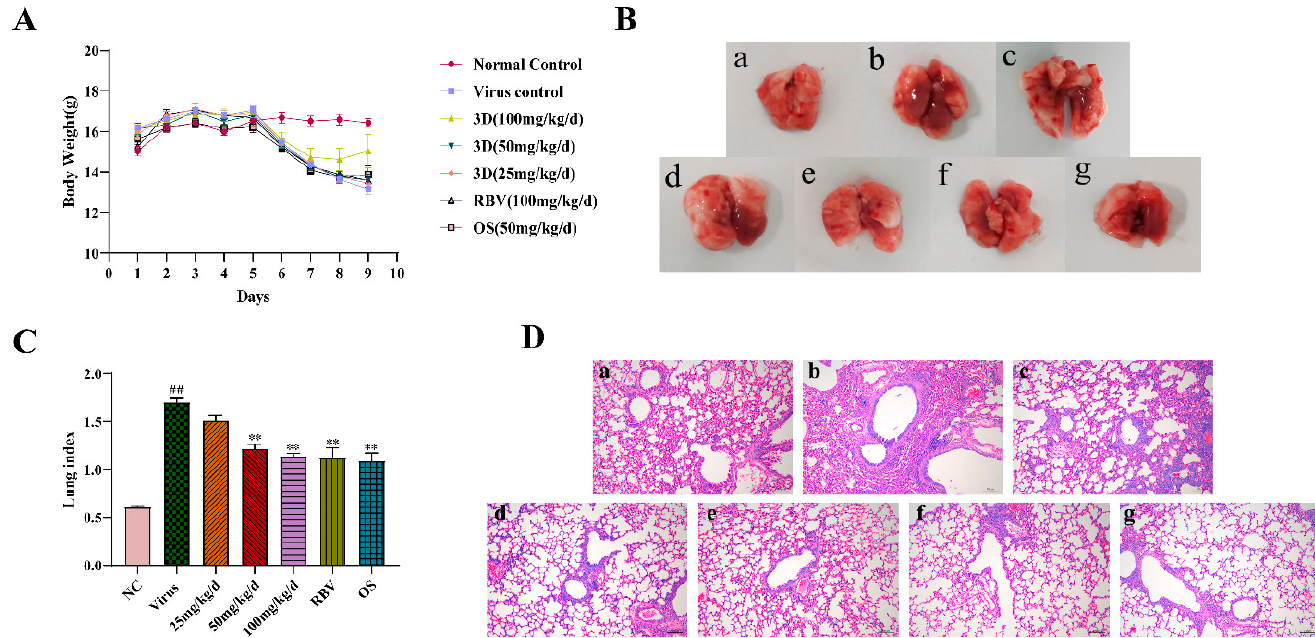
Figure 6. Evaluation of therapeutic efficacy of 3D in vivo. After three days for adaption, mice were mock-infected or infected with A/Weiss/43 H1N1. Mice were intragastrically administered with different compounds once a day for six consecutive days. ( A ) Body weight was monitored every day. ( B ) At six days post-infection, lungs were harvested, observed, and weighed. ( C ) The lung indexes were calculated and analyzed. ( D ) Photomicrographs of histopathology in lung tissue with HE staining were recorded (100×). Data are shown as the mean ± SD. ( ## p < 0.01 compared with the normal control; ** p < 0.01 compared with the virus control.) ( B ) and ( D ) samples from (a) the normal control group; (b) the virus control group; (c) the 3D low-dose group, (d) the 3D middle-dose group, (e) the 3D high-dose group, (f) the ribavirin group, and (g) the oseltamivir group.